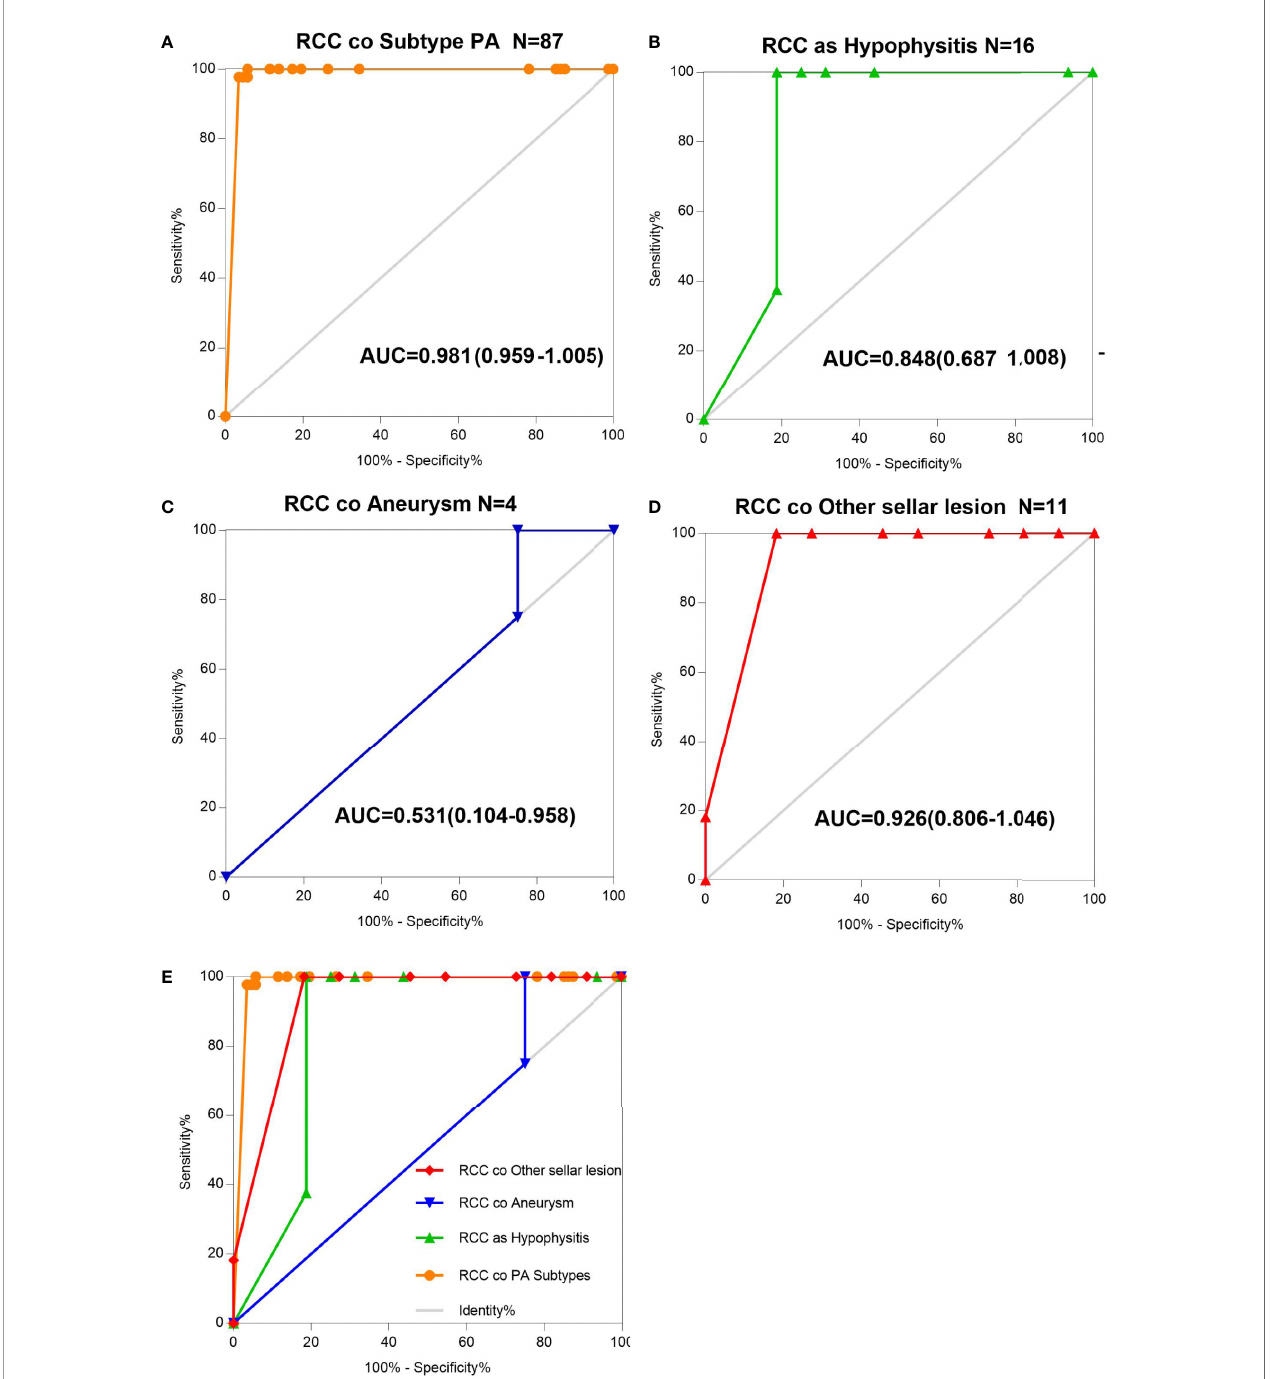
FIGURE 2 | AUC determination using receiver operating characteristic (ROC) curves. (A) Information on the results of age group value markers and RCC coexisting with pituitary adenoma subtype, assessed by the AUC. (B) Information on the age group value markers and RCC coexisting with hypophysitis, assessed by the AUC. (C) Information on the age group value markers and RCC coexisting with aneurysm, assessed by the AUC. (D) Information on the age group value markers and RCC coexisting with other sellar lesions, assessed by the AUC. (E) RCC and various sellar lesions in 118 patients classi fi ed into fi ve groups according to different sellar lesions. Total ROC